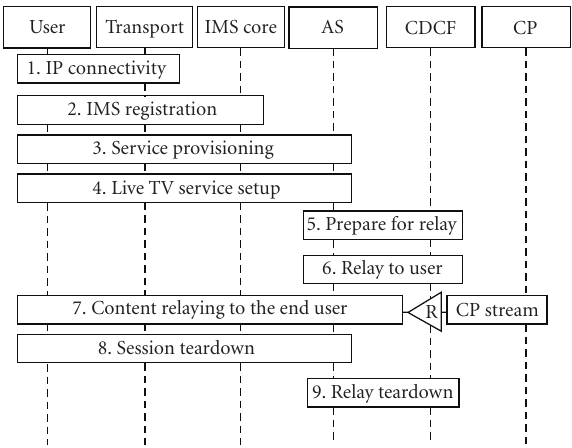
Figure 5: Session setup of a live TV service.